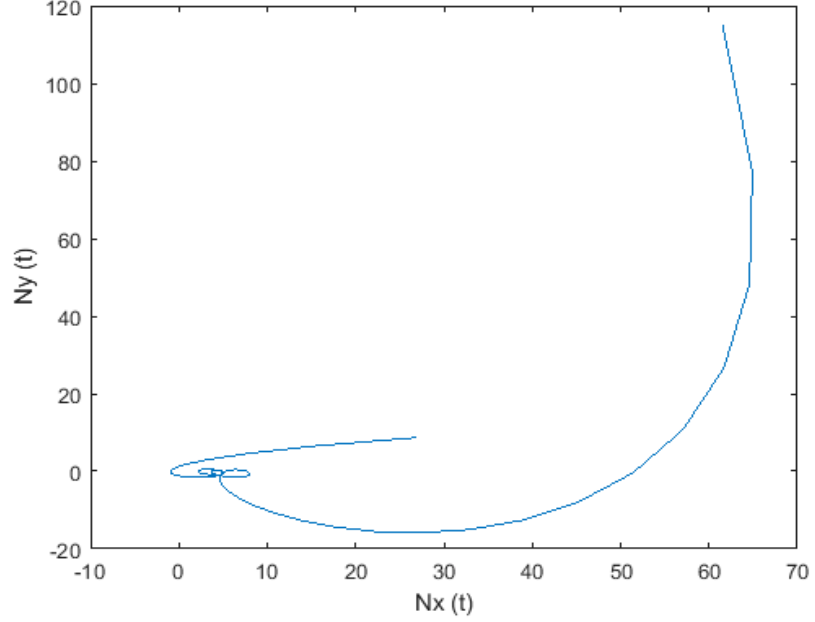
(cid:16) (cid:17) N x vs. N y with parameters: